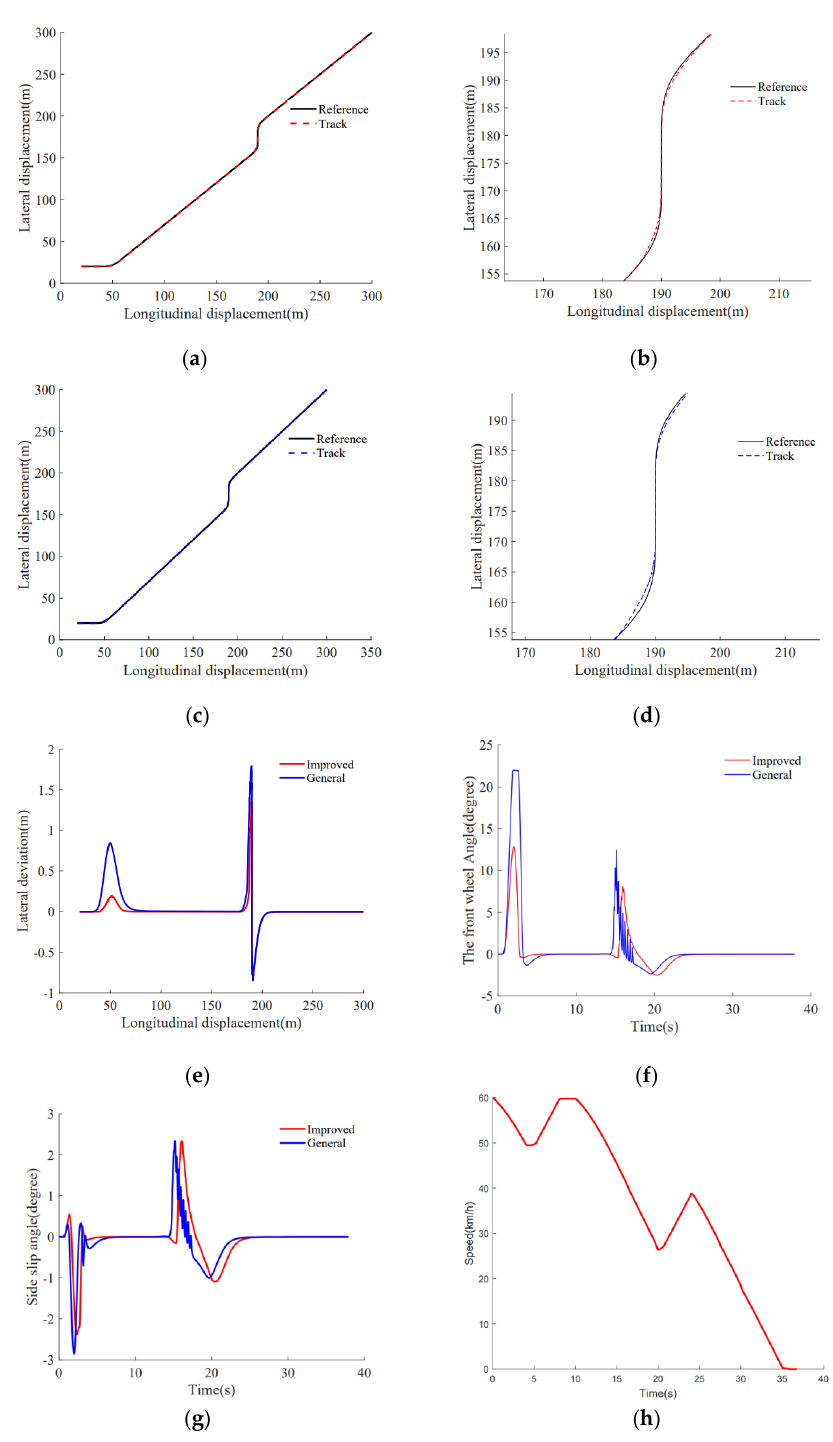
( d ) Figure 11. The chatter test: ( a ) maximum test 1; ( b ) test 2; ( c ) test 3; ( d ) minimum test 4. 5.4. Matlab-Carsim HIL Simulation Platform Test Figure 12 shows the comparison experimental image of the Matlab-Carsim HIL sim- ulation platform between the improved terminal sliding mode control and the general terminal sliding mode control. The initial speed was 60 km/h. As shown in Figure 12a, the improved algorithm tracks the desired trajectory image. The black represents the desired trajectory, and the red–dotted line represents the tracking trajectory. Figure 12b shows a partial enlarged image of the improved algorithm tracking the desired trajectory. As